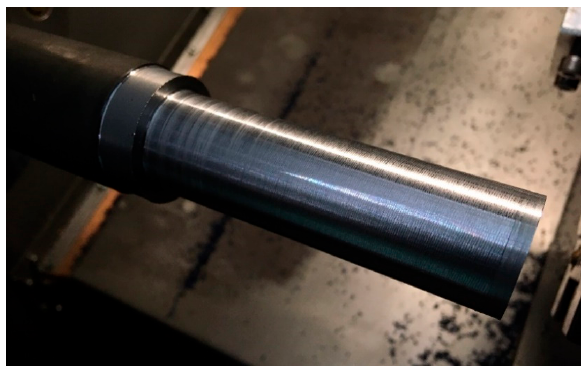
Figure 16. Surface after machining without the system supporting the selection of technological parameters.